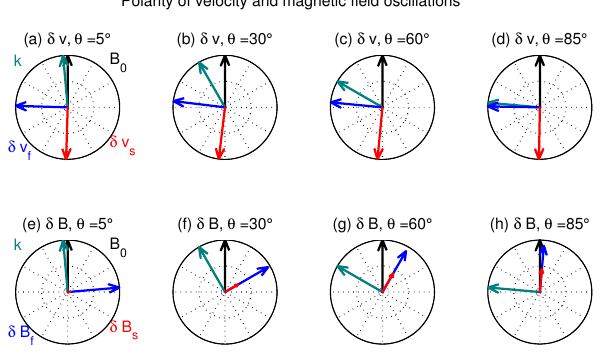
Figure 3. Polarity relations when v A = 2, c s = 1 and ρ 0 = 1. (a) to (d) show directions of velocity oscillations of fast and slow modes with different θ kB . (e) to (h) show directions of magnetic field os- cillations of fast and slow modes. In each panel, the arrow length of δ B is scaled proportional to δ v